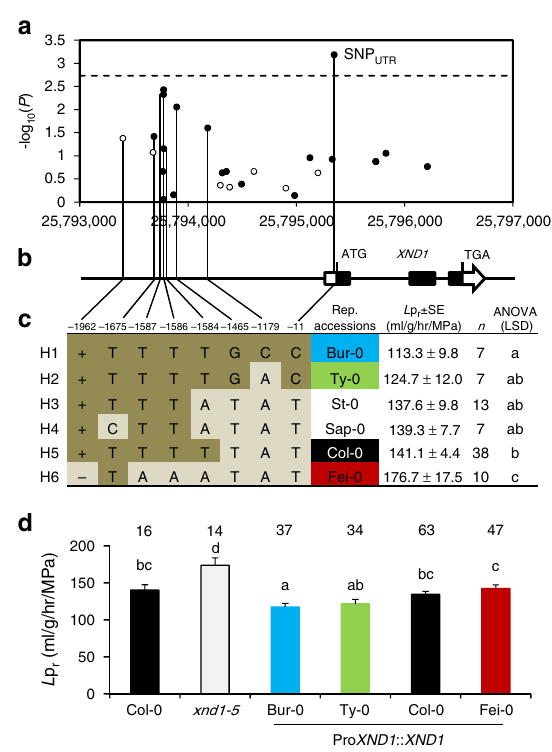
Fig. 2 A XND1 -based association analysis allows re fi ning the natural allelic variations of XND1 . a The association with L p r of 27 polymorphic sites (MAF > 0.05) in the indicated XND1 genomic region was investigated in a set of 112 accessions. The x -axis shows the nucleotide position of each variant, with empty and fi lled circles indicating INDELs and SNPs, respectively. The y -axis shows the – log 10 ( P ) for the association tests, with the signi fi cance threshold at α = 0.05 indicated with a dashed line. b The eight polymorphisms selected for further analysis are projected onto a schematic representation of XND1 gene structure. For position − 1962, + and − represent an insertion and deletion, respectively. The boxes represent exons, with solid and empty boxes showing translated and untranslated regions, respectively. The SNP at Chr 5-P25,795,349 that surpassed the signi fi cance threshold in a is located in the 5 ’ -UTR of XND1 and indicated as SNP UTR . c The eight selected nucleotide polymorphisms (with their distance from translation start site shown on the top) de fi ne six haplogroups (H1 – H6). Representative accessions and mean L p r ± SE within each haplogroup ( n , accessions number) are shown. One-way ANOVA (Fisher ’ s LSD, P < 0.05) was used to test the signi fi cance of the L p r data. d Transgenic complementation of xnd1 – 5 with different allelic forms of XND1 . The L p xnd1 – 5 , and xnd1 – 5 plants expressing XND1 genomic r of Col-0, fragments from Bur-0, Ty-0, Col-0, or Fei-0, was tested using 3 – 5 independent transgenic lines per XND1 allele (see Supplementary Figure 5). Mean values ± SE ( n = 14 – 63 plants) are shown with sample size indicated on the top. One-way ANOVA (Fisher ’ s LSD, P < 0.05) was used to test